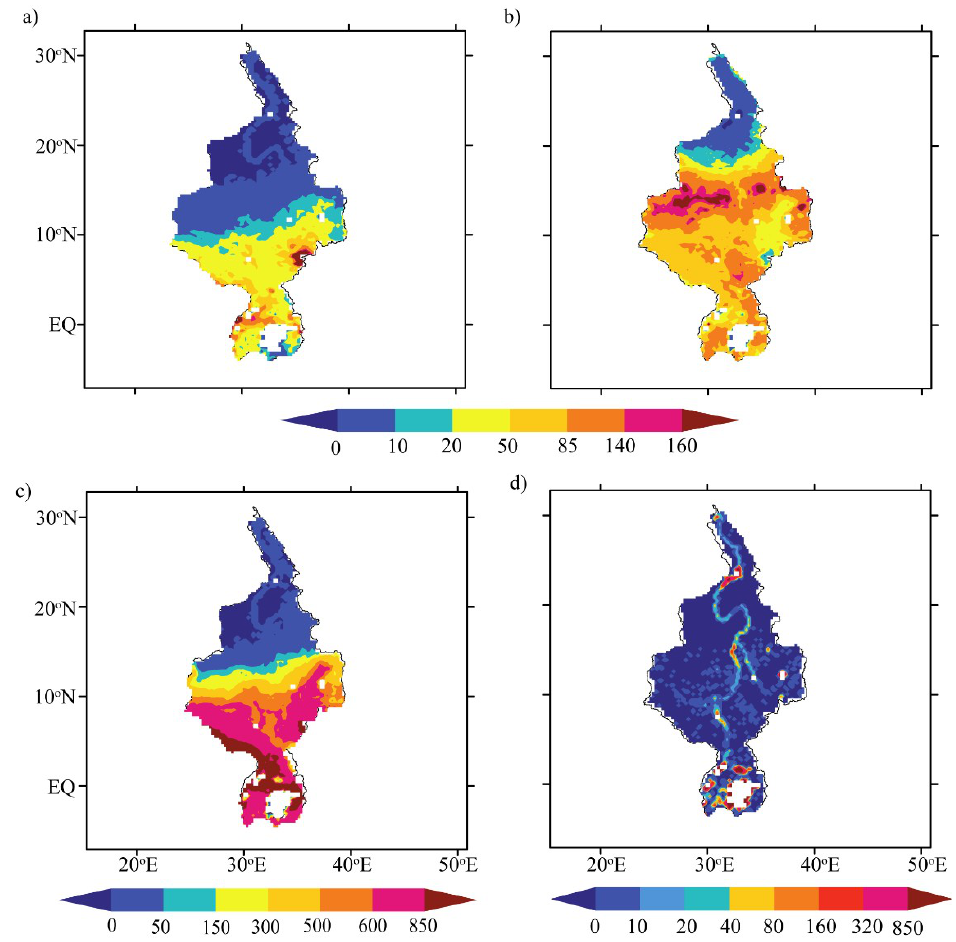
Figure 8. Annual amounts of di ff erent components of total ET in the Nile Basin for the period 1980–2014 (unit: mm): ( a ) bare-soil evaporation (E b ), ( b ) canopy interception (E i ), ( c ) vegetation transpiration (E t ), and ( d ) open-water evaporation (E w ).